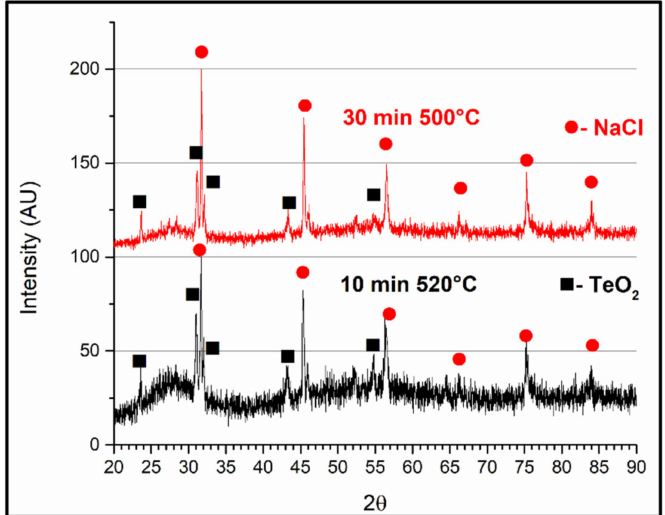
Figure 6. X-ray di ff raction (XRD) patterns of the coated samples following thermal treatments of 500 ◦ C for 30 min (Red) and 520 ◦ C for 10 min (Black).